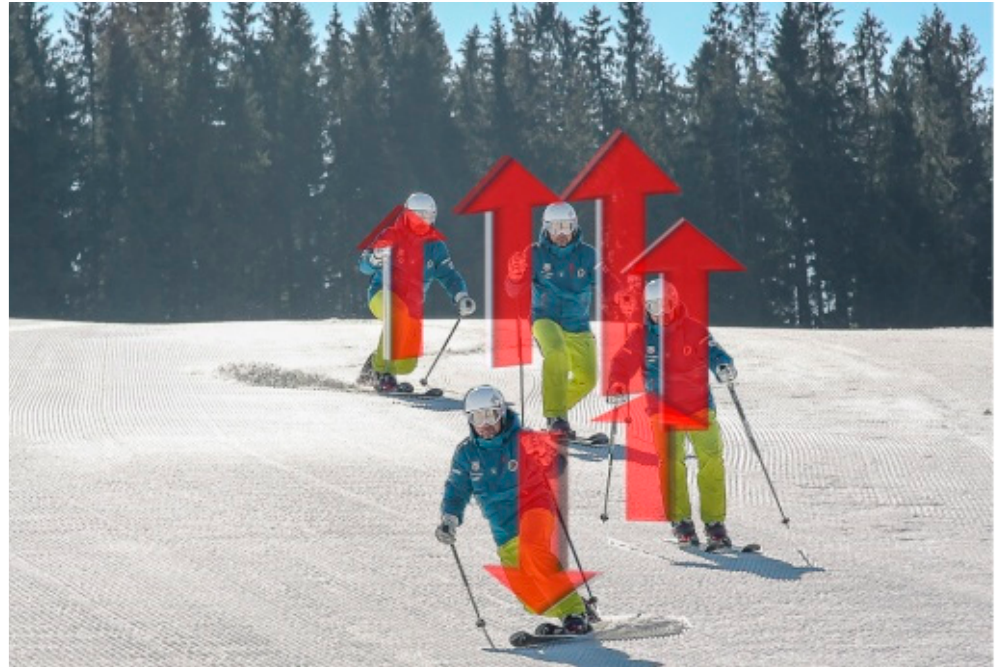
Figure 4. Unloading the skis in Telemark turn (the arrows show the vertical movement of the